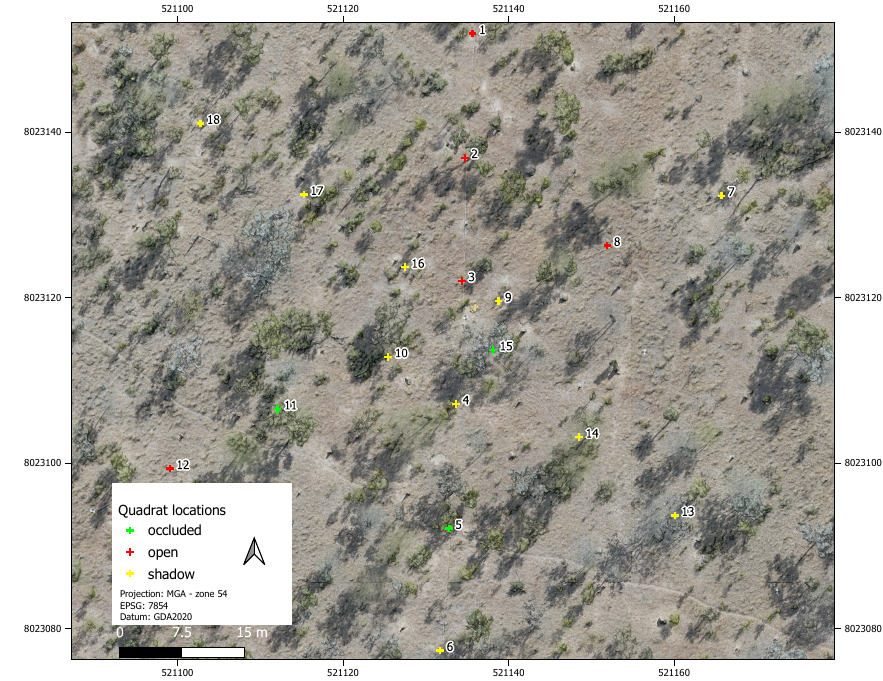
Figure 5. Example orthomosaic imagery of a woodland field site to highlight the extent of tree and shrub cover. Occlusion of the sampling quadrats are illustrated as well as those quadrats that were in shadow at time of